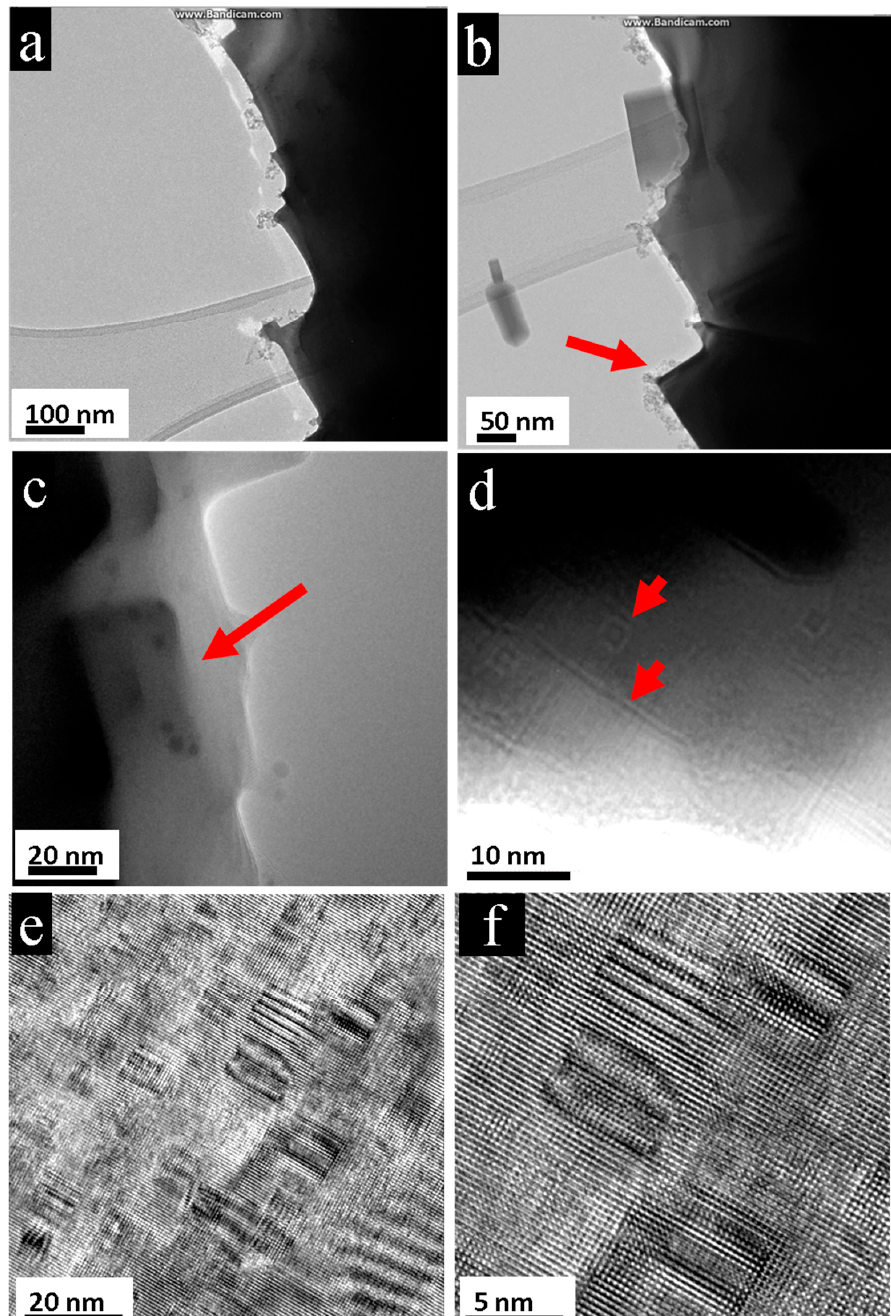
Figure 2. Nanostructuring of PbTe crystal before and after electron-beam irradiation. ( a , b ) During and after irradiation, the crystal shows clear geometric rectangular boundaries. ( c , d ) Transparent edges of the irradiated aggregate where the shapes of nano-cubes become evident, follow red arrows. ( c ) Large cube of about 40 nm. ( d ) Smaller and nested cubes from 2 to 8 nm. ( e , f ) The initial crystal exhibits clear nanopatterning: nano-cubes ranging mainly from 5 to 15 nm.